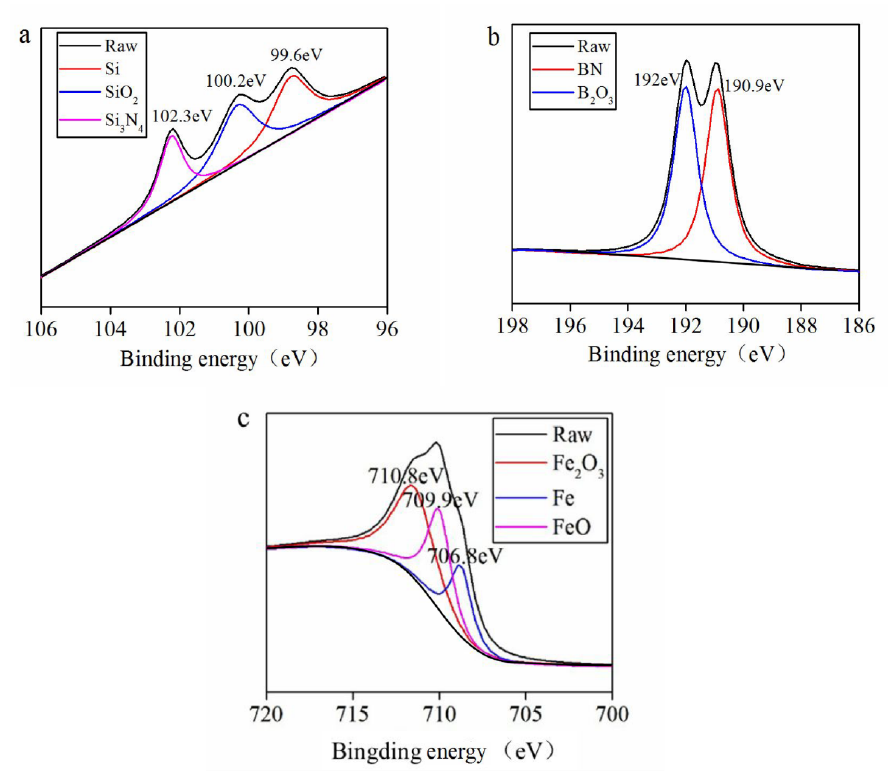
Figure 8. XPS spectrum of Si 2p ( a ), B 1s ( b ), and Fe 2p 3 / 2 ( c ) on the worn surface of the GCr15 disc sliding against the SN10 pin in the pure-water environment.